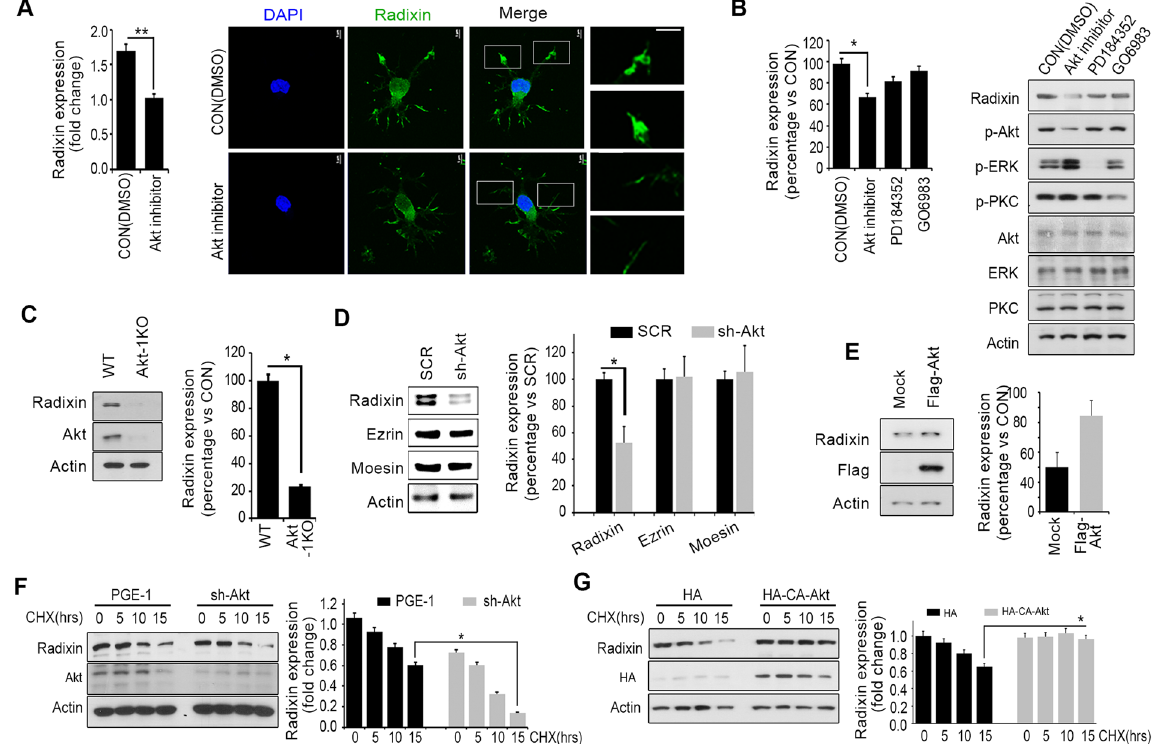
Figure 1. Akt regulates radixin protein stability. ( A ) Hippocampal neurons were treated with a vehicle (DMSO) or Akt inhibitor VIII for 4 h, and radixin expression was examined by immunofluorescence. Enlargement of the boxed area is shown on the right. Scale bar, 50 μ m or 5 μ m. Enlargement boxes indicate radixin positive filopodia at the axon tip. The bar graph shows radixin immunoreactivity (fluorescence intensity) in the axon. ( B ) PC12 cells were treated with Akt inhibitor VIII (1 μ M), ERK/MAPK inhibitor PD184352 (1 μ M) or the protein kinase C (PKC) inhibitor GO6983. Amounts of total and phosphorylated Akt, MAPK, and PKC were determined by immunoblotting (IB). * p < 0.05, ** p < 0.005 versus indicated. Densitometric values are mean ± SEM from three independent experiments, and the image shown is representative of at least three independent experiments. ( C ) Akt1-KO MEFs were cultured and subjected to immunoblotting analysis with the indicated antibodies. ( D ) PC12 cells were transfected with sh-Akt, and after 48 h, cell lysates were subjected to IB with the indicated antibodies. Densitometric quantification analysis is shown by the bar graph. ( E ) PC12 cells transfected with the flag-Akt or flag control constructs followed by IB. ( F ) Transfected PC12 cells were treated with CHX (20 μ M) for the indicated times, and lysates were probed by IB (upper). Knockdown of Akt was confirmed by IB, and radixin protein levels were quantified by densitometry (bottom). ( G ) PC12 cells were transfected with HA-CA (constitutively active form)-Akt or HA-mock vector and treated with cycloheximide (CHX, 20 μ M) as indicated time. Half –life of radixin was confirmed by IB and quantification of the radixin protein levels by densitometry analysis (bottom). Values in this figure represent mean ± SEM from three independent experiments and image shown here is representative from at least three independent experiments. The uncropped blot images are shown in Supplementary Fig.